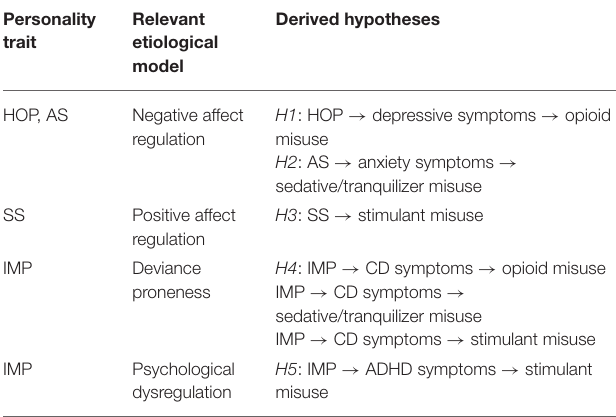
TABLE 1 | Summary of theories and hypotheses. Personality